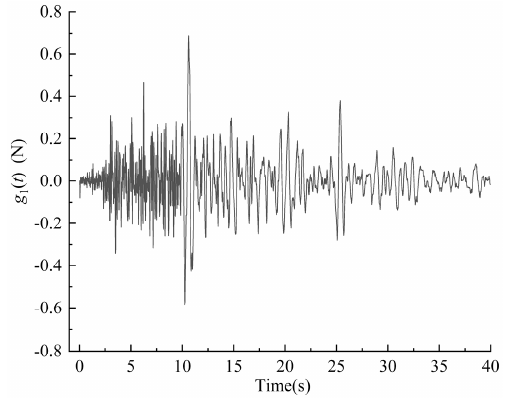
Figure 3. Equivalent real-valued force g 1 ( t ).